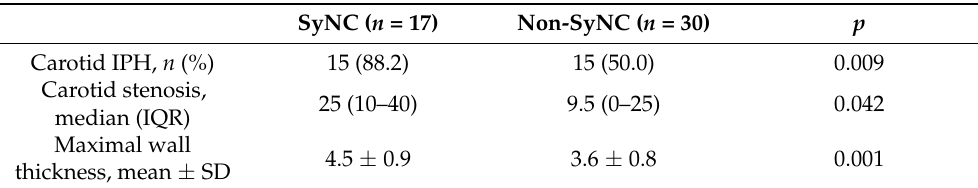
Table 2. Morphological analysis of carotid plaques between symptomatic nonstenotic carotid disease and non-symptomatic nonstenotic carotid disease groups. SyNC ( n = 17)